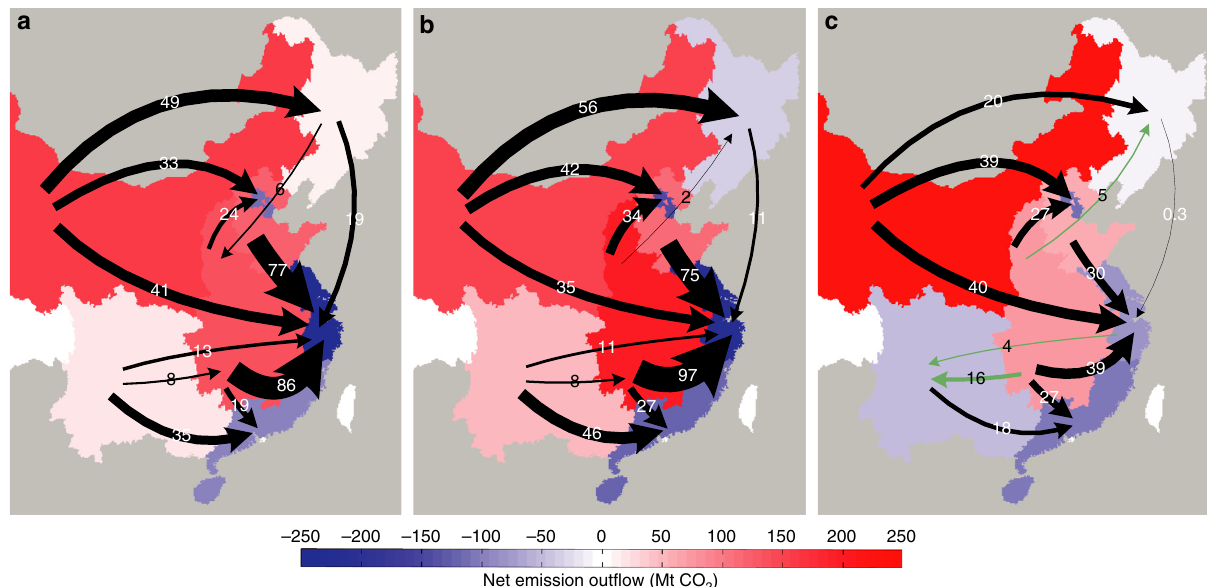
Fig. 3 Changes in emission fl ow patterns within China. a Net emission out fl ows in 2007, b Net emission out fl ows in 2010, c Net emission out fl ows in 2012. The sizes of arrows correspond to the amount of net emission fl ows, and green arrows mean that net emission out fl ows reversed between 2007 and 2012. Mt CO 2 means million tonnes of carbon dioxide. The net emission fl ows to eastern coastal provinces declined from 2007 to 2012, and Southwest and Northeast China shifted from being net emission exporters to net emission